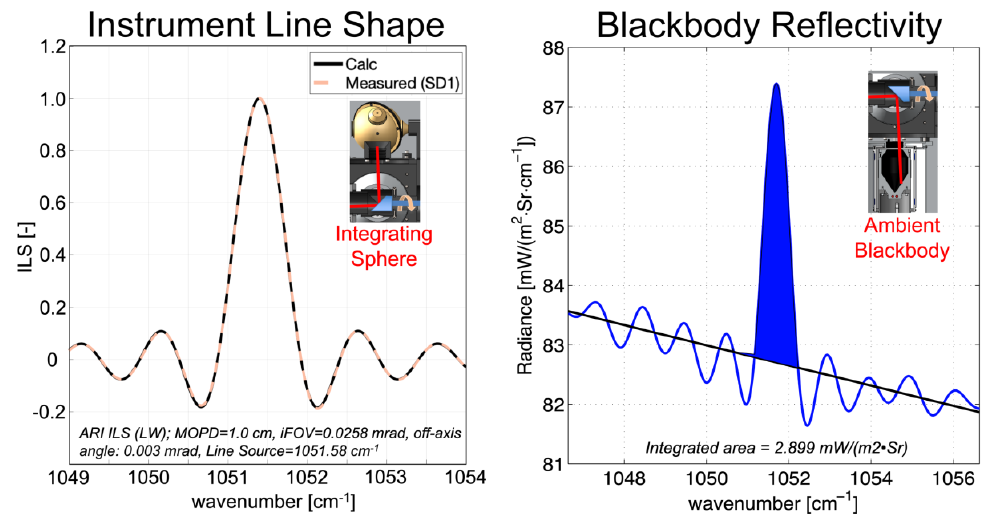
Figure 25. ARI ILS measurement ( left ) and Ambient Blackbody reflectivity measurements obtained using the QCL ( right ). In the plot on the right, the blue curve is the measured radiance when the blackbody is illuminated with the QCL, the black curve is the radiance from the blackbody without QCL illumination, and the blue region is a measure of the laser power reflected from the blackbody.